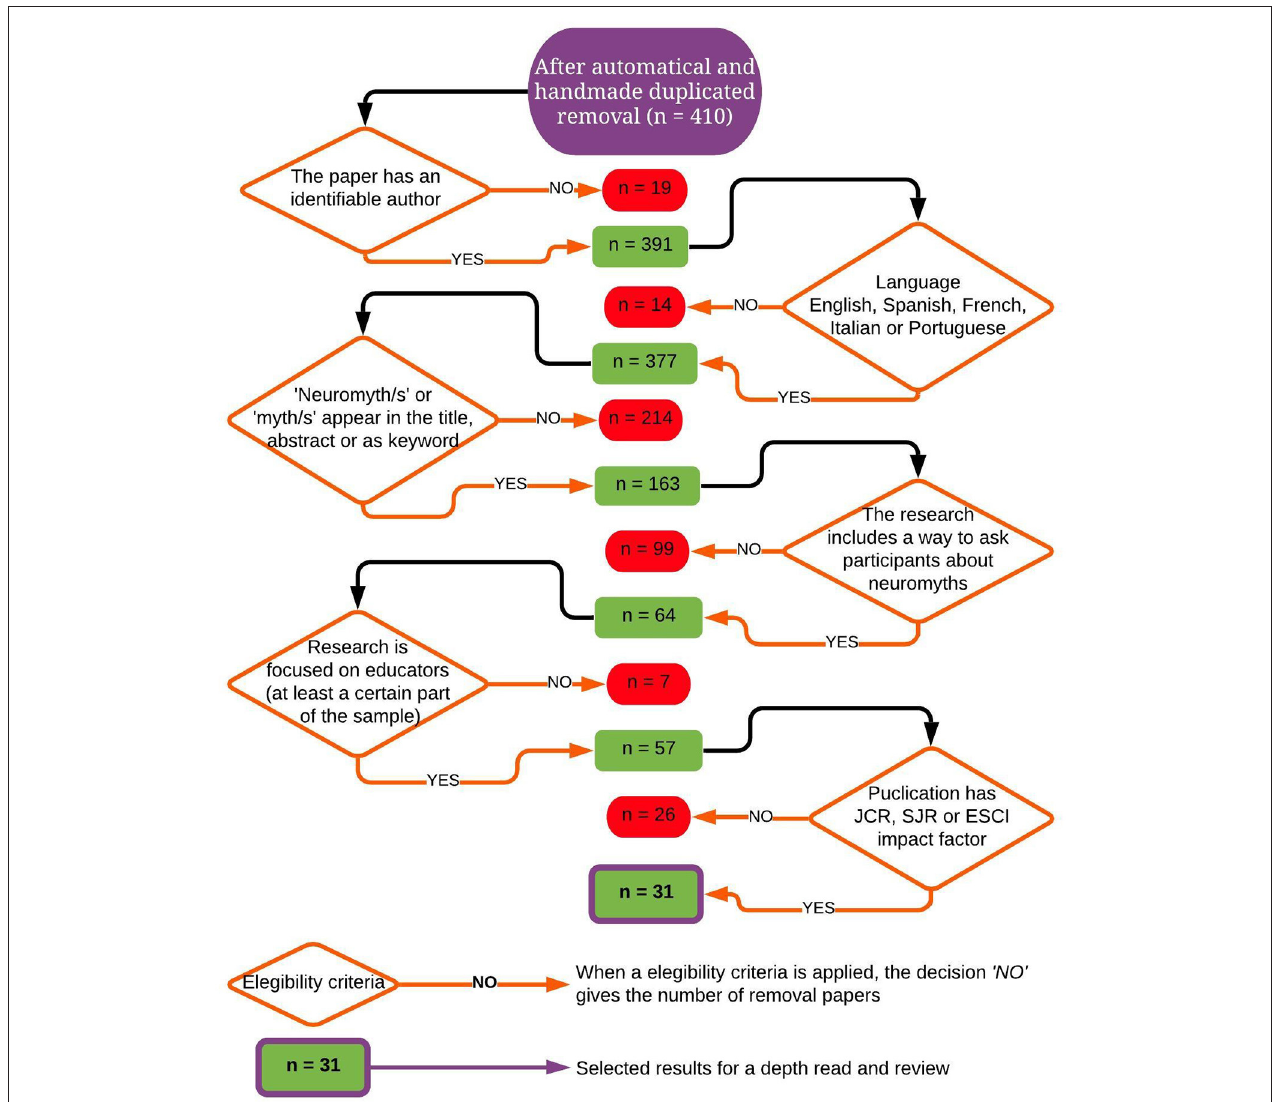
FIGURE 3 | Inclusion and exclusion criteria: decision